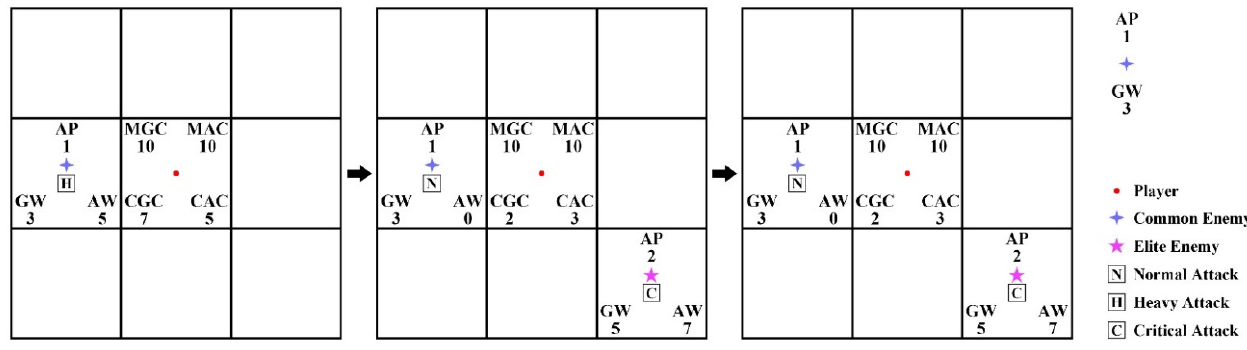
Figure 1. Combat example.